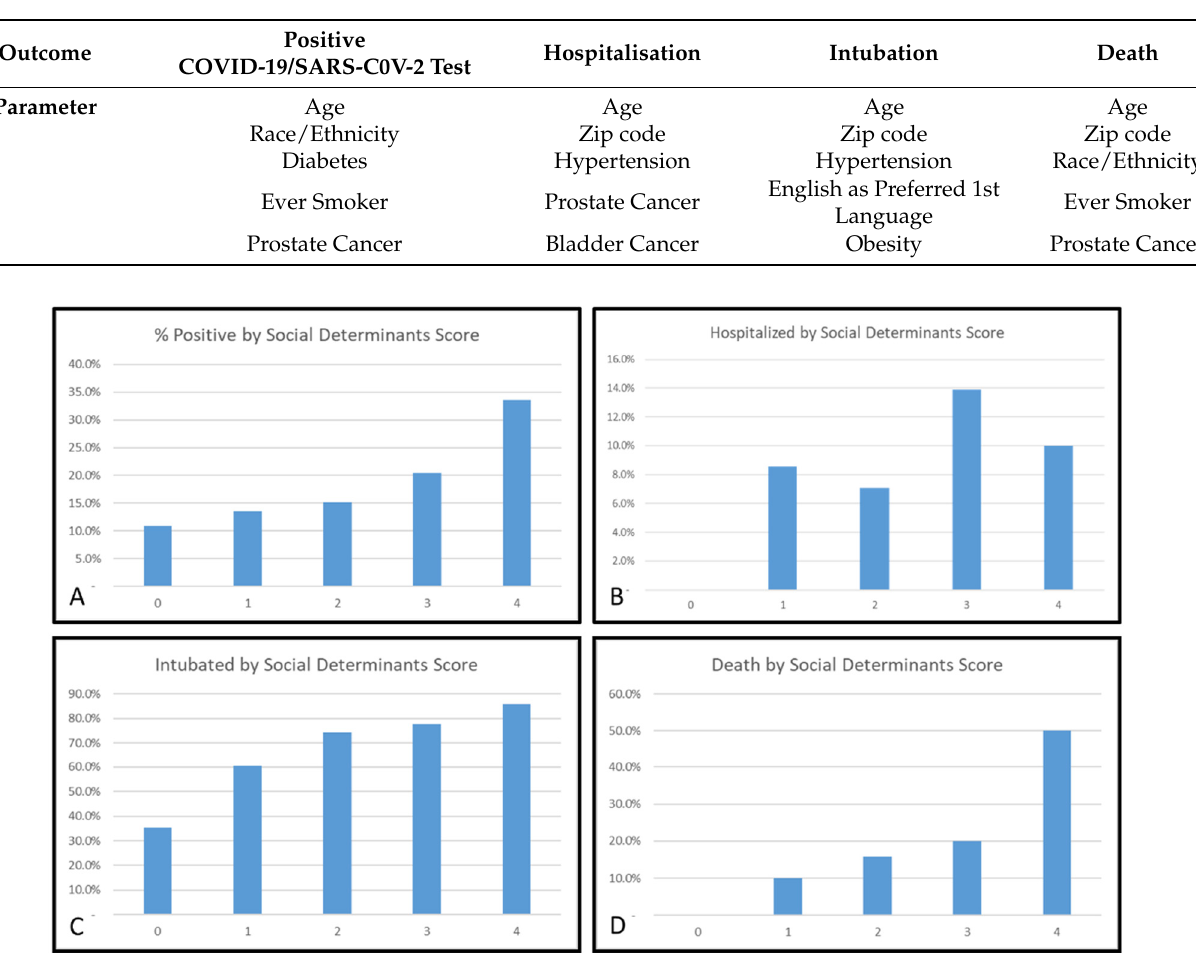
Table 2. The most parsimonious parameters as identified EFS analysis for each of this study’s outcomes: risk of testing positive for SARS-CoV-2 infection and COVID-19-related hospitalisation, intubation and death in a cohort of patients with genitourinary cancers.